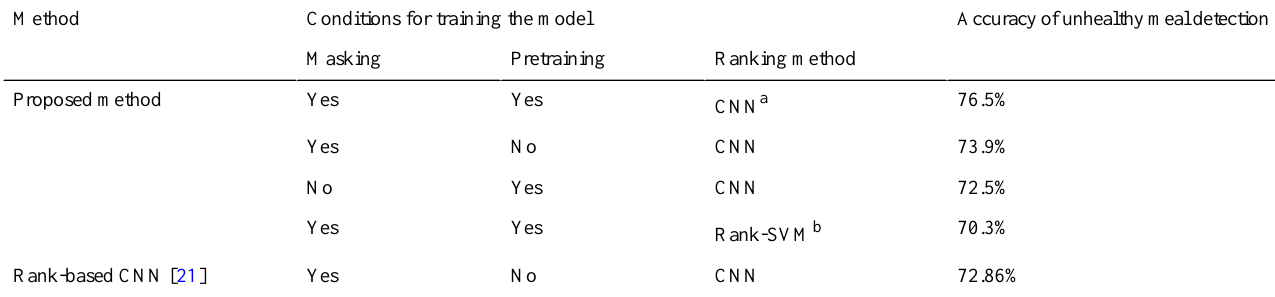
Table 2. Evaluation of the accuracy of unhealthy meal